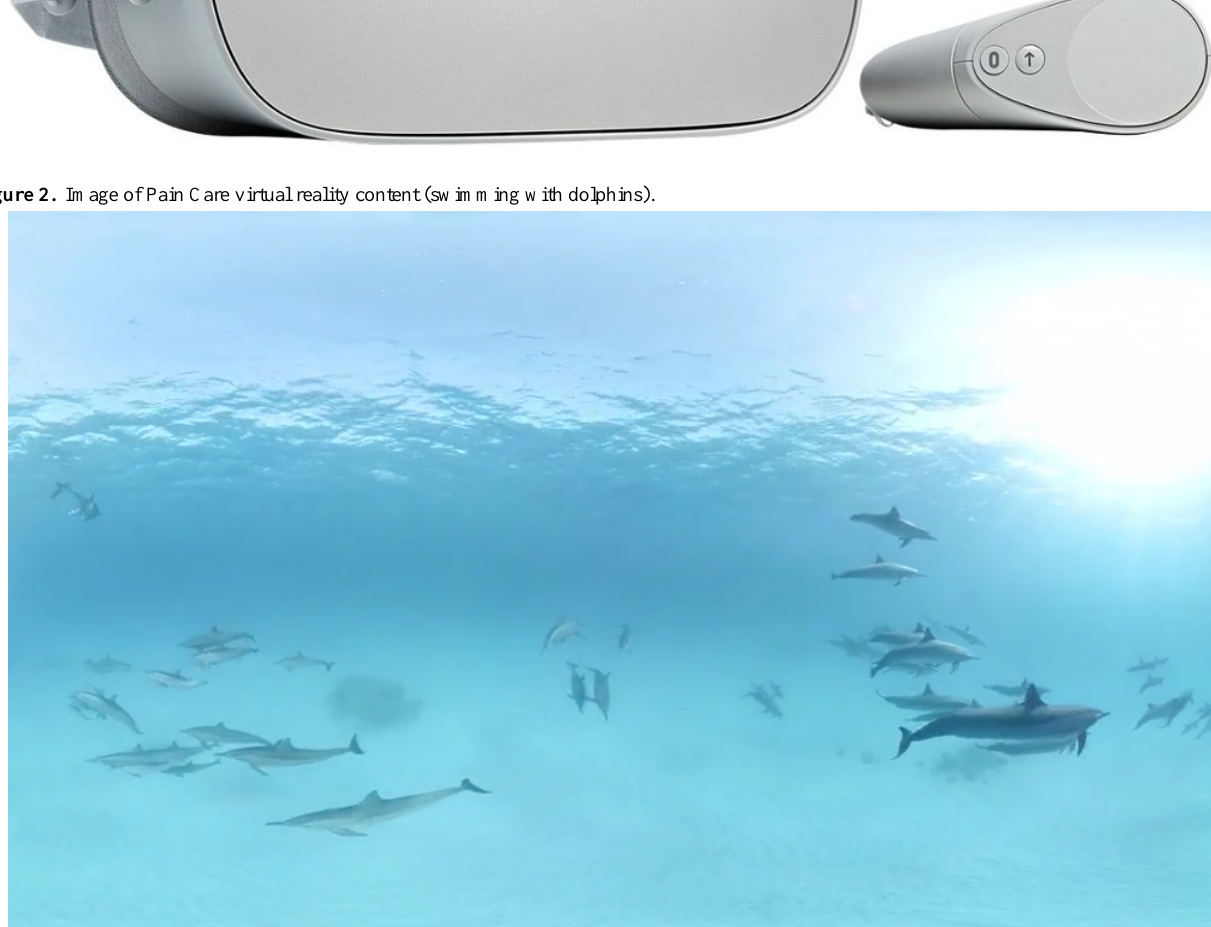
Figure 2. Image of Pain Care virtual reality content (swimming with